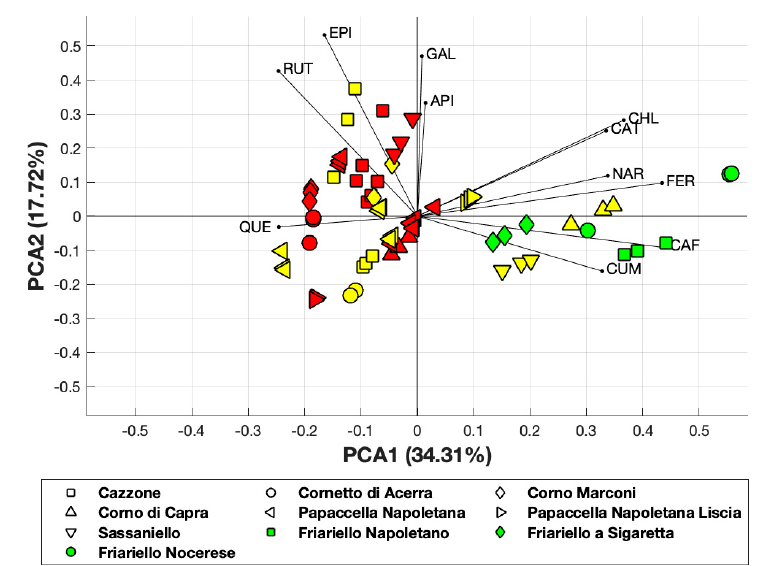
Figure 4. PCA obtained considering polyphenol composition. Yellow and red-colored symbols indicate the yellow and red varieties, respectively.